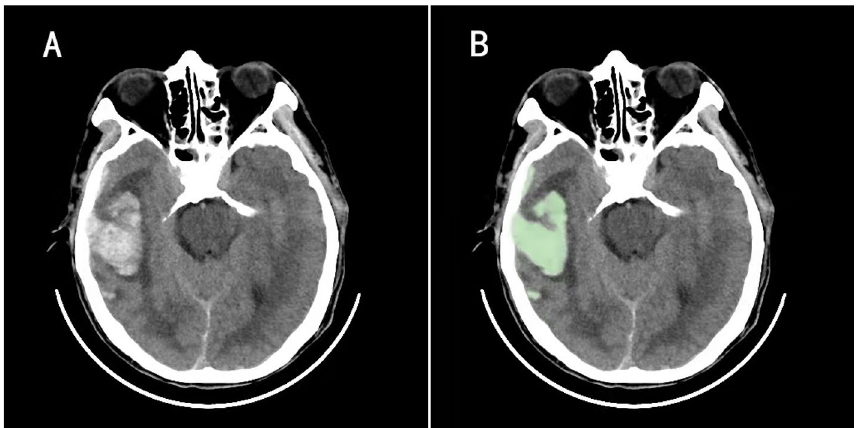
Figure 2. On the 3D slicer software, the contusion volume is provided by manually selecting the region of interest, setting the threshold based on the Hounsfield unit (the fixed thresholds of 110 and 50 HU) to distinguish the contusion part from the surrounding normal brain tissue, and automatically summarizing the adjacent voxels (A and B).